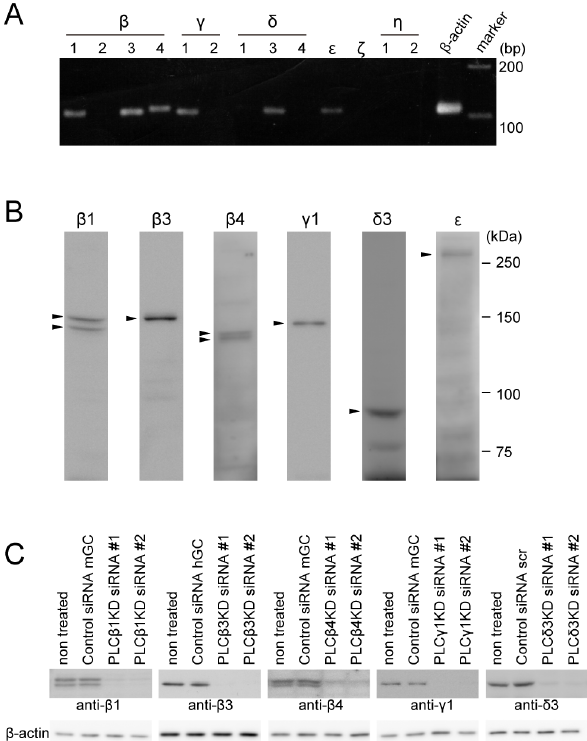
Figure 3. Identification of PLC isozymes expressed in HeLa cells and their specific knockdown using siRNAs. (A) Results of RT-PCR analyses using total RNA isolated from HeLa cells. (B) Western blotting analyses of endogenous PLC isozymes expressed in HeLa cells using isozyme-specific antibodies. Molecular mass markers are shown on the right. (C) Western blotting analyses of total lysates prepared from HeLa cells treated with PLC isozyme-specific siRNAs. The antibodies used are shown at the bottom. The results are representative of at least three independent experiments.